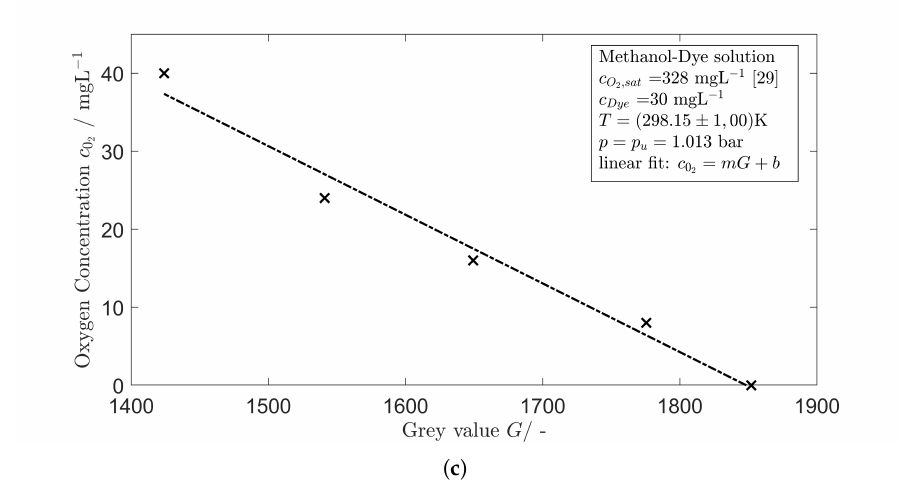
Figure 3. ( a ) Raw image of a rising oxygen bubble in the methanol-dye solution. ( b ) Processed image, yielding the concentration field behind a rising oxygen bubble (wobbling). ( c ) Example of a calibration fit (dashed line) through measurement points (black x) used for concentration determination according to